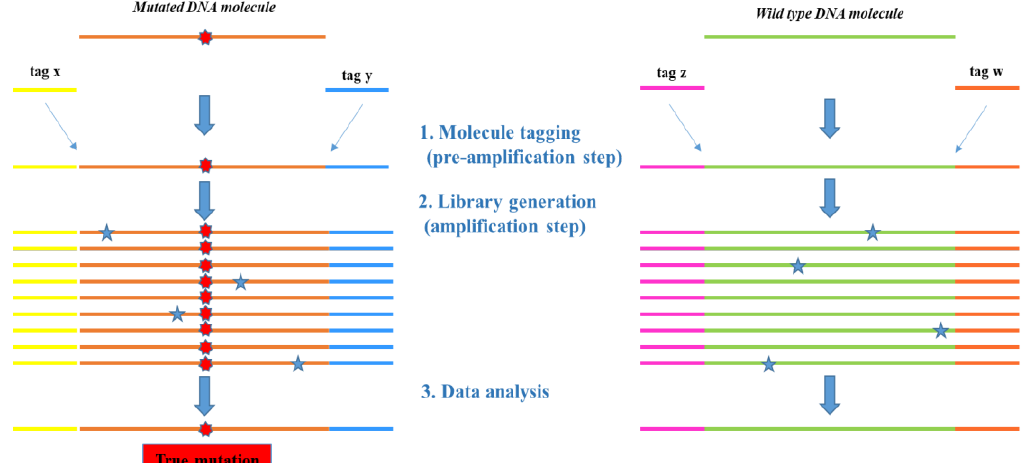
Figure 5. Overall principle of sequencing based on molecular tagging NGS approach. Unique molecular tags bound to gene-specific primers are added into every DNA molecule (Step 1) prior to the library amplification step, in order to keep track of possible PCR and/or sequencing artifacts (blue stars). All of the reads (Step 2) are then collapsed with the same genomic coordinates and molecular tag into a single representative read (Step 3), corresponding to an original mutated (on the left) or wild-type (on the right) DNA template.